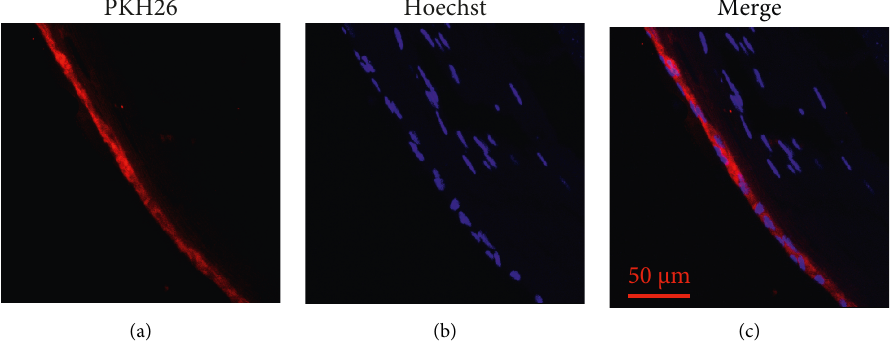
Figure 5: Equatorial LECs uptake of PKH26-labeled exosomes was detected using confocal microscopy after lens cultured ex vivo for 7 days. Red represents PKH26; blue represents the nucleus. Scale bar � 50 μ